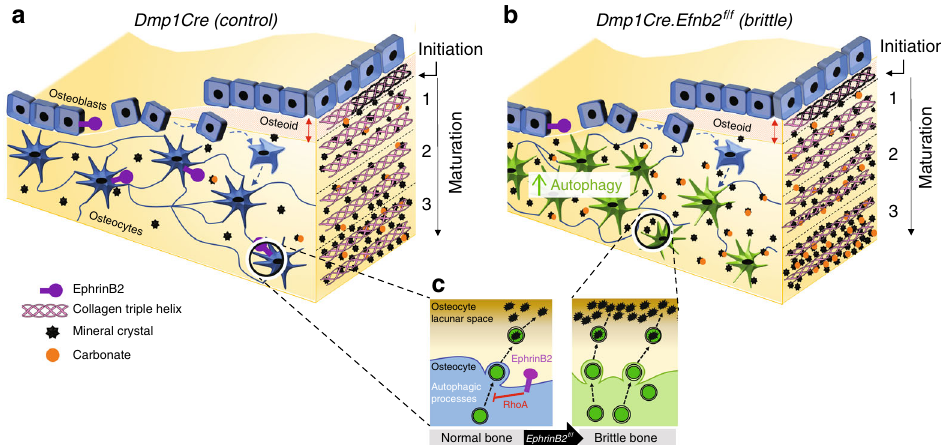
Fig. 8 Model of osteocytic EphrinB2 regulation of bone matrix composition. a In control bone ( Dmp1Cre ) both osteoblasts and osteocytes express EphrinB2. Osteoblasts reside on the bone surface, and pass through a transition (dashed arrows) to become mature, matrix-embedded osteocytes. Osteoblasts deposit collagen-containing osteoid (triple helical collagen fi bers, shown on the right). In region 1 of newly formed bone, mineral deposition is initiated. Mineral crystals (black stars) and carbonate (orange circles) continue to accumulate, and collagen fi bers become more compact as the matrix matures in regions 2 and 3. b Dmp1Cre.Efnb2 f/f mice express EphrinB2 in osteoblasts, but not osteocytes. Dmp1Cre.Efnb2 f/f osteocytes have increased autophagy (green cells). Osteoid deposition occurs normally, and the initiation of mineralization commences at the same rate, leading to osteoid of the same thickness (red double-headed arrow). As soon as mineralization starts, mineral is deposited in Dmp1Cre.Efnb2 f/f bone at a greater level than control in regions 1, 2, and 3 to reach a level with more mineral, more carbonate substitution, and more compact collagen fi bers than controls. Ultimately this leads to more brittle bone. c Close-up of the cell membrane in osteocytes in control and Dmp1Cre.Efnb2 f/f bone: we propose that, in control mice, EphrinB2 suppresses autophagic processes and limits matrix vesicle release via RhoA-ROCK signalling. In Dmp1Cre.Efnb2 f/f mice loss of this inhibition leads to a high level of matrix